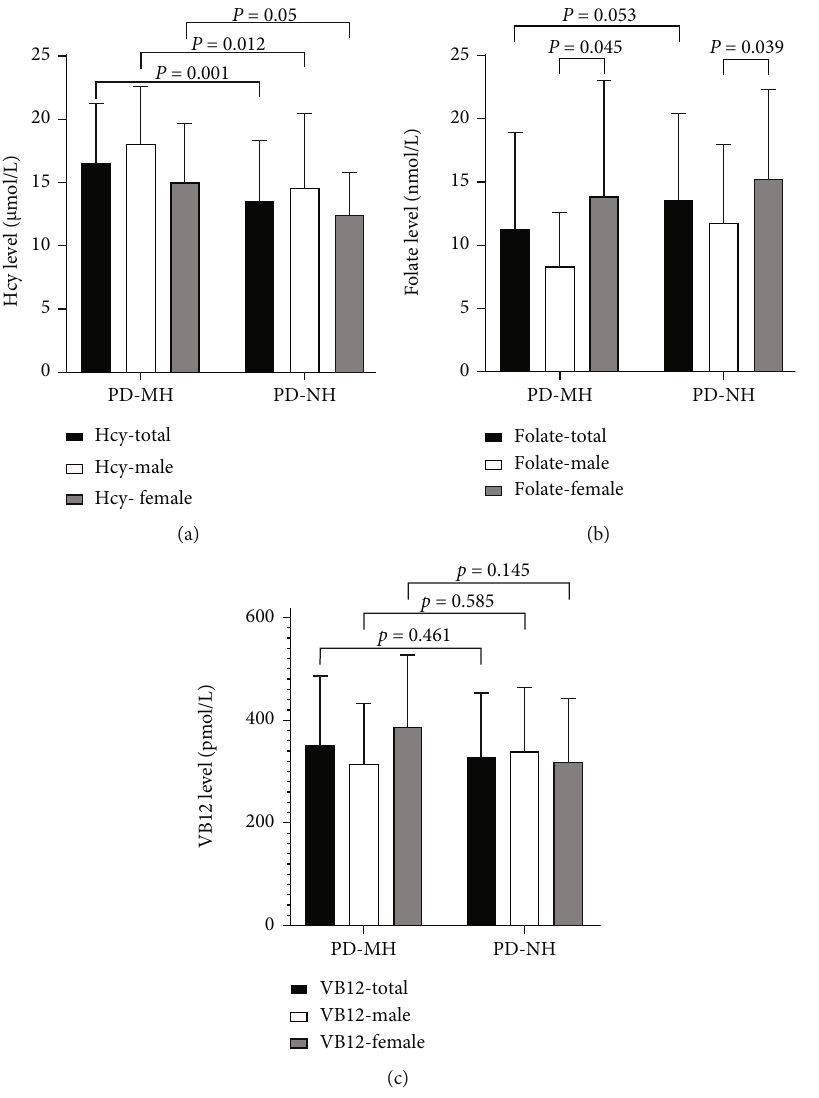
Figure 3: Comparison of Hcy, folate, and vitamin B12 levels between MH and NH patients, according to gender. (a) Comparison of Hcy level between the PD-MH and PD-NH groups. PD-MH (total) vs. PD-NH (total), P = 0 : 001 ; PD-MH (male) vs. PD-NH (male), P = 0 : 012 ; PD-MH (female) vs. PD-NH (female), P = 0 : 05 . (b) Comparison of folate level between the PD-MH and PD-NH groups. PD-MH (total) vs. PD-NH (total), P = 0 : 053 ; PD-MH (male) vs. PD-MH (female), P = 0 : 045 ; PD-NH (male) vs. PD-NH (female), P = 0 : 039 . (c) Comparison of vitamin B12 level between the PD-MH and PD-NH groups. PD-MH (total) vs. PD-NH (total), P = 0 : 461 ; PD-MH (male) vs. PD-NH (male), P = 0 : 585 ; PD-MH (female) vs. PD-NH (female), P = 0 : 145 . Hcy: